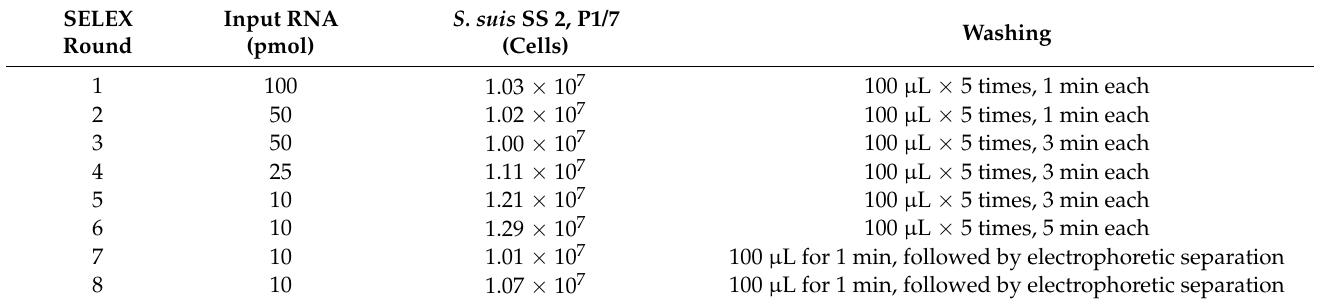
Table 2. The aptamer selection protocol for cell-SELEX using S. suis SS 2, P1/7 as target